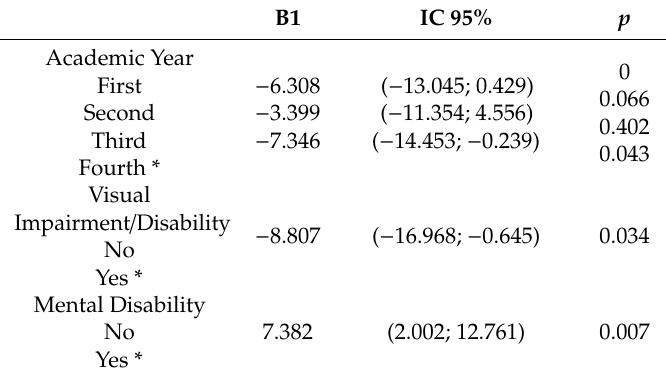
Table 5. Factors related to attitudes towards